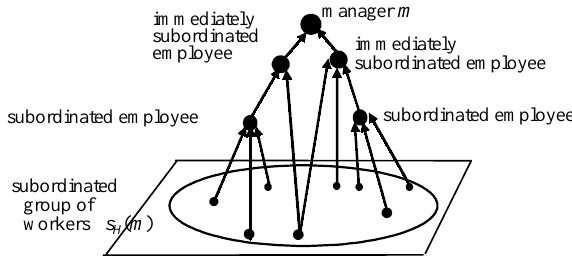
Fig 1 . An example of manager and subordinated group of